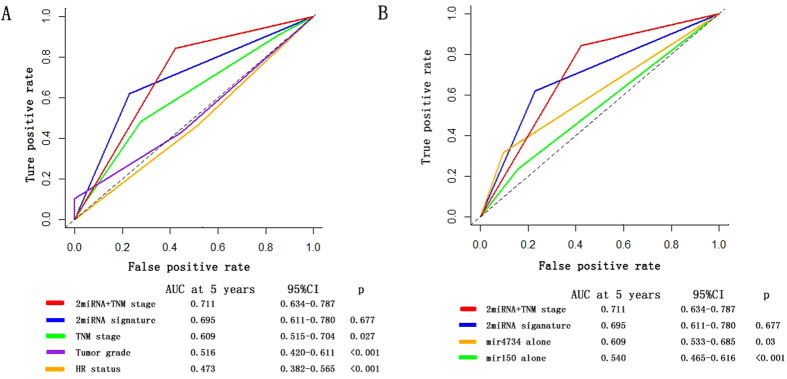
Time-dependent ROC curves compare the prognostic accuracy of the 2-miRNA based signature with clinicopathological risk factors and single miRNAs in all 211 patients with HER2 positive breast cancer.ROC = receiver operator characteristic. AUC = area under curve. HR = hormonal receptor. (A) Comparisons of the prognostic accuracy by the two-miRNA-based signature (high risk vs low risk), TNM stage (Stage1 vs Stage2 vs stage 3), pathological tumor grade (high vs low), and the miRNA signature and TNM stage combined. (B) Comparisons of the prognostic accuracy by the two-miRNA-based signature (high vs low risk), the miRNA signature and TNM stage combined, the miR-4734 alone (high vs low expression) and miR-150-5p alone (high vs low expression).